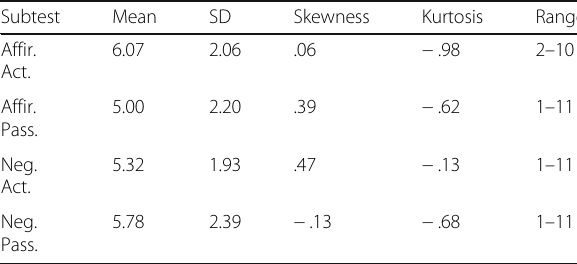
Table 2 Descriptive statistics for the subtests of